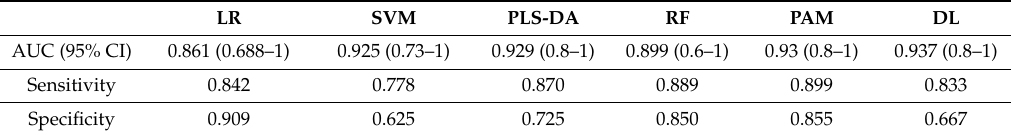
Table 3. Results for the various predictive modeling techniques